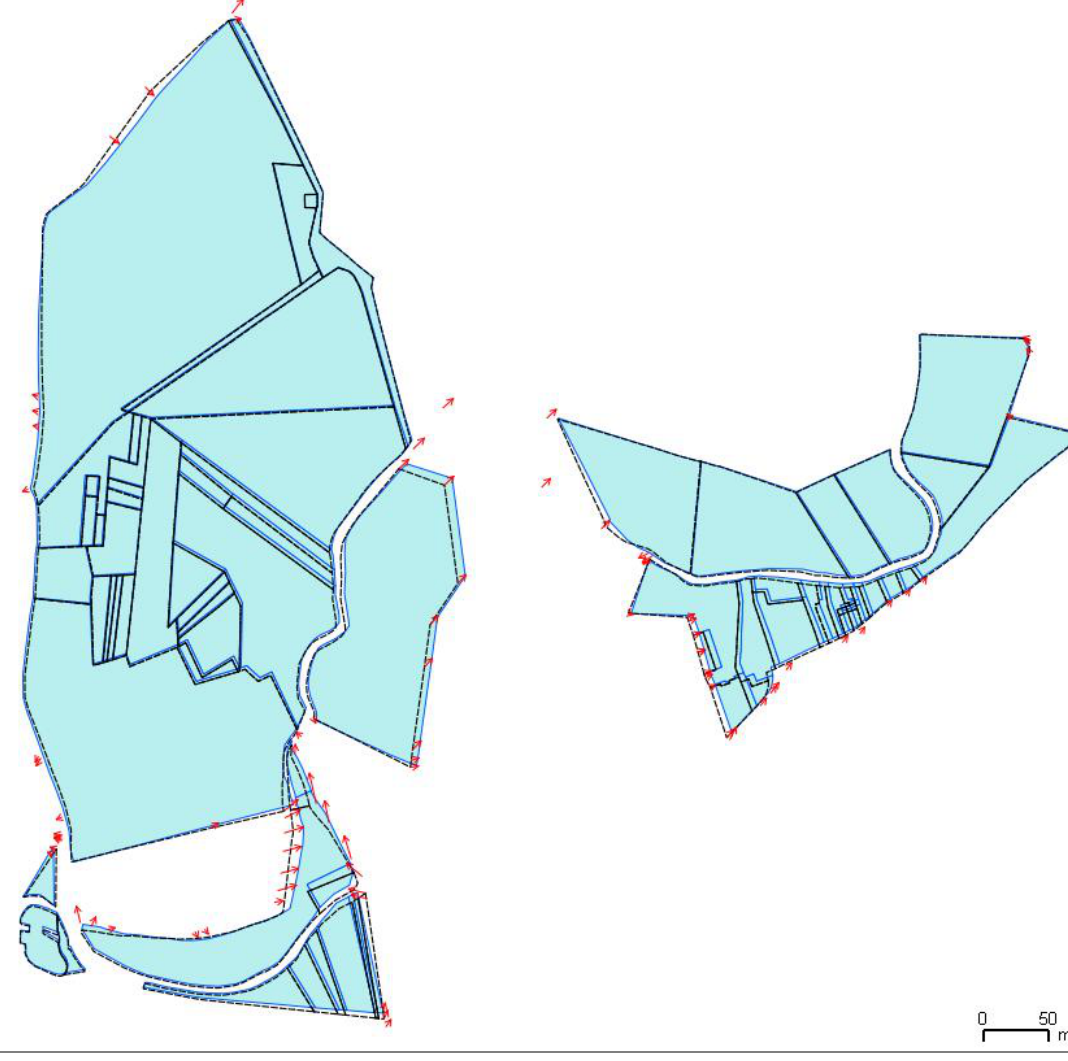
Figure 19. Propagation of the least squares conflation to buildings inside parcels: Initial geometries drawn with dashed